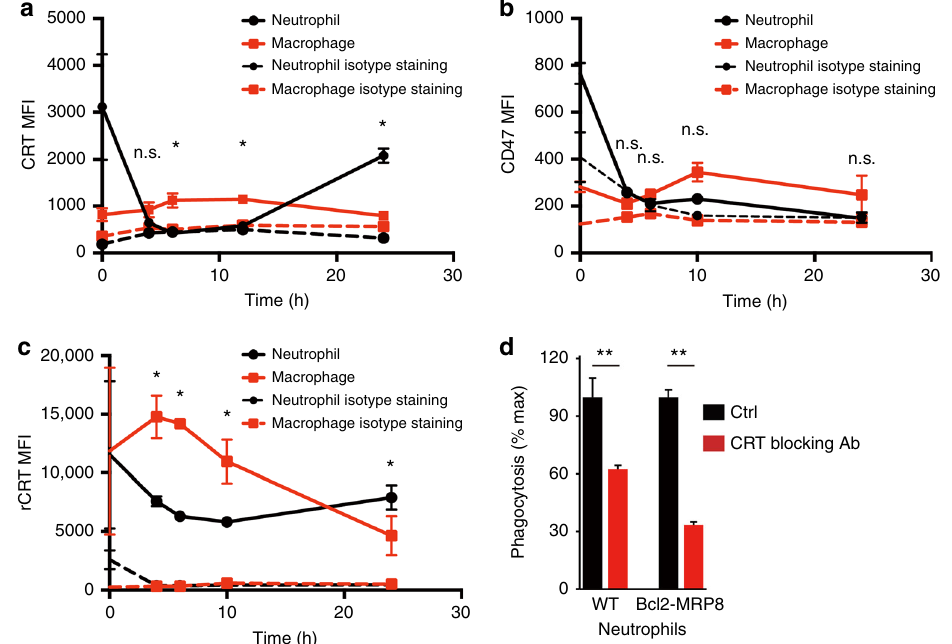
Fig. 2 Cell surface CRT determines programmed cell removal of neutrophils in peritonitis. a , b Cell surface levels of CRT on macrophages and neutrophils after thioglycollate injection to MRP8-Bcl2 mice. Peritoneal cells were collected and analyzed at 0, 4, 6, 12, and 24 h after thioglycollate injection, by fl ow cytometry analysis. Results are representatives of three independent experiments. n = 3 mice for each time points. * P < 0.05 (paired t -test) for CRT staining between macrophages and neutrophils at the same time points. Error bars represent standard deviation. b Cell surface levels of CD47 on macrophages and neutrophils after thioglycollate injection to MRP8-Bcl2 mice. Peritoneal cells were collected and analyzed at 0, 4, 6, 10, and 24 h after thioglycollate injection, by fl ow cytometry analysis. Results are representatives of three independent experiments. n = 3 mice for each time point. n.s. (paired t -test) so signi fi cant differences for CD47 staining between macrophages and neutrophils at the same time points. Error bars represent standard deviation. c Binding of recombinant CRT to macrophages and neutrophils after thioglycollate injection to MRP8-Bcl2 mice. Peritoneal cells were collected and analyzed at 0, 4, 6, 10, and 24 h after thioglycollate injection. CRT-binding sites on macrophages and neutrophils were measured by incubating the cells with saturation concentration of recombinant CRT and analyzing by fl ow cytometry. Results are representatives of three independent experiments. n = 3 mice for each time point. * P < 0.05 (paired t -test) for rCRT staining between macrophages and neutrophils at the same time points. Error bars represent standard deviation. d An in vitro phagocytosis assay showing blockade of CRT inhibits phagocytosis of neutrophils, with WT and Bcl2